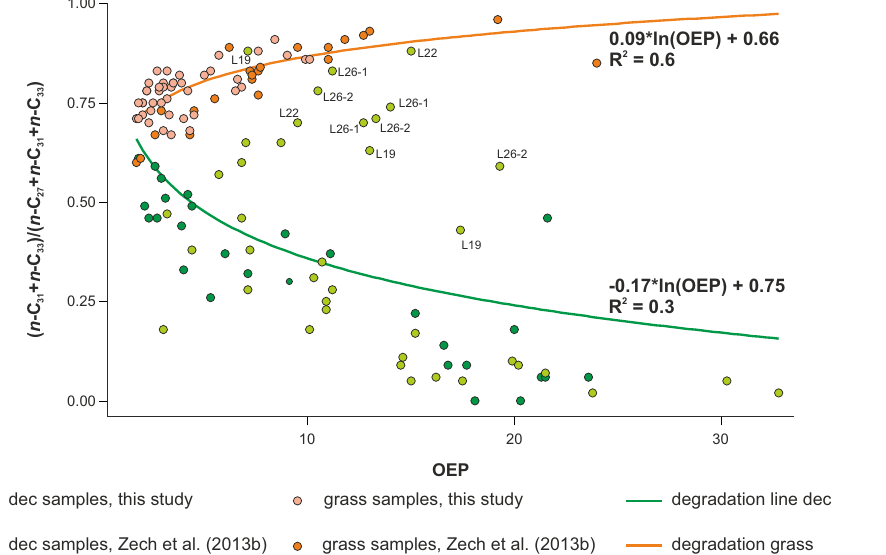
Figure 8. Endmember plot modified after Zech et al. (2013b). Degradation lines refer to the complete dataset. Samples that deviated markedly from the degradation lines are labelled and discussed in the